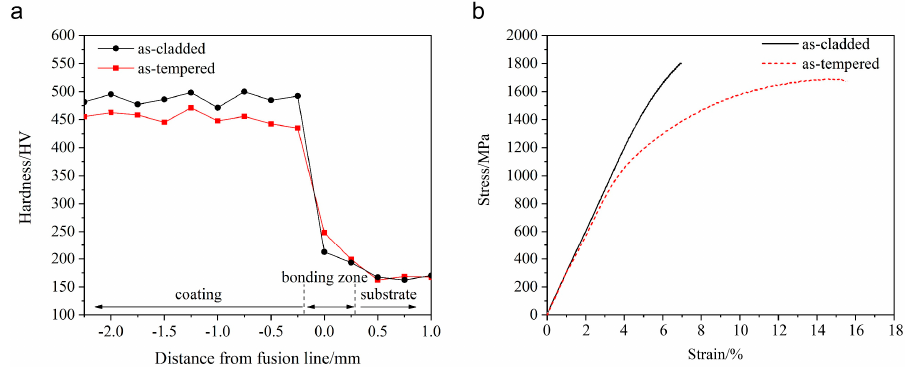
Figure 6. Mechanical properties of the specimens: ( a ) micro-hardness distribution profiles of the cross-section specimens; ( b ) tensile curve of coatings. Table 2. Comparison of the Tensile Properties from different laser cladded Fe-based SS